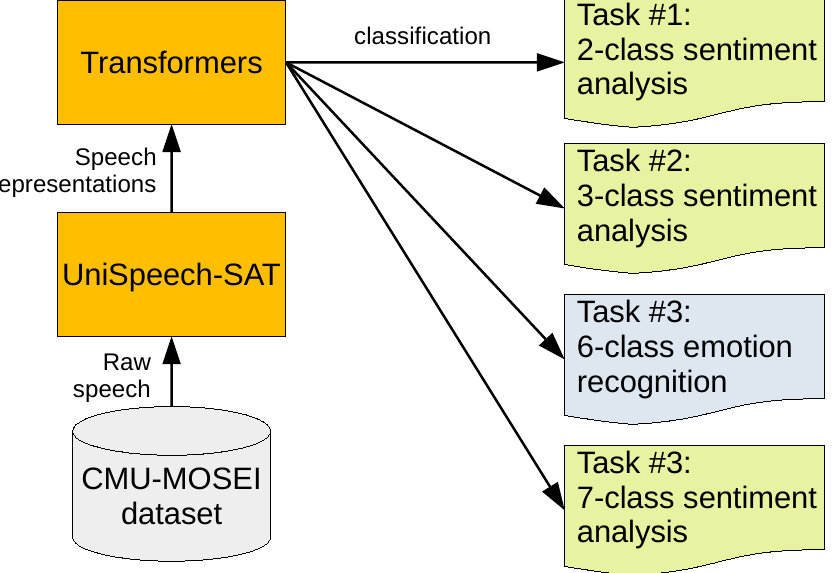
Figure 1. Flow diagram of the data processing method from the dataset to each classification